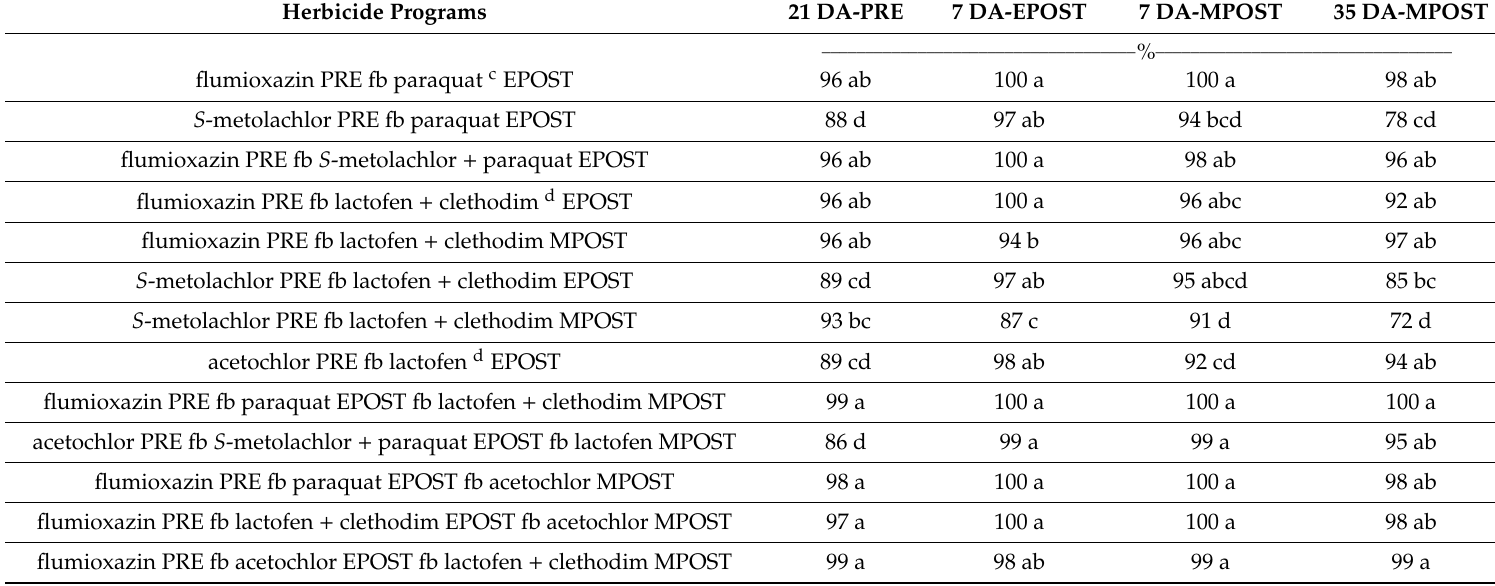
Table 6. Control of pitted morningglory 21 DA-PRE, 7 DA-EPOST, and 7 and 35 DA-MPOST b treatments in Weed Control Study at Stoneville, MS, averaged over 2017 and 2018 a